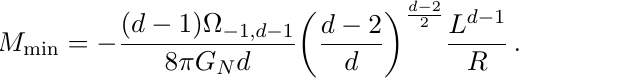
where M is the minimal value of min